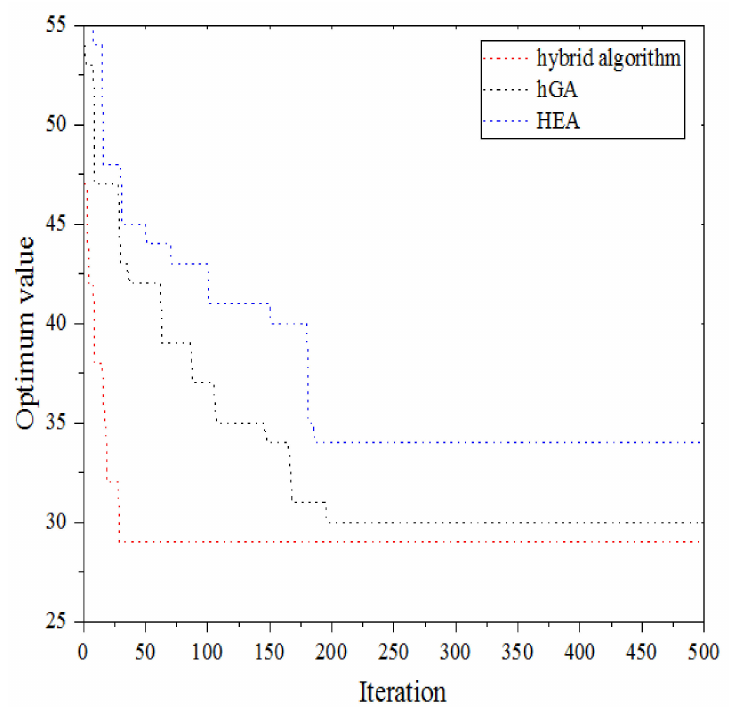
Figure 7. Comparison with mentioned hybrid algorithms for optimizing